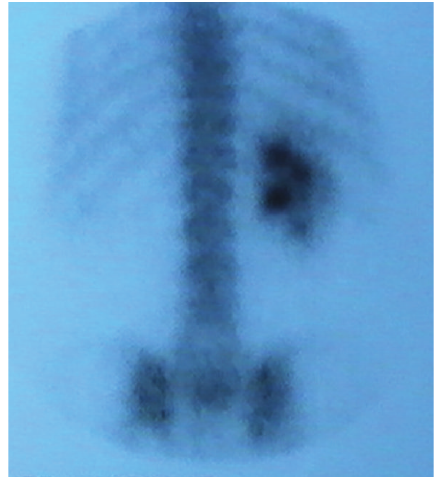
Figure 7: Tc-99m methylene diphosphonate scintigraphy: unilat- eral left renal